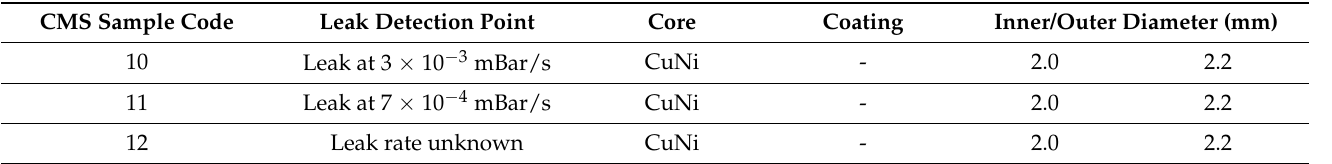
Table 2. List of leaky pipe